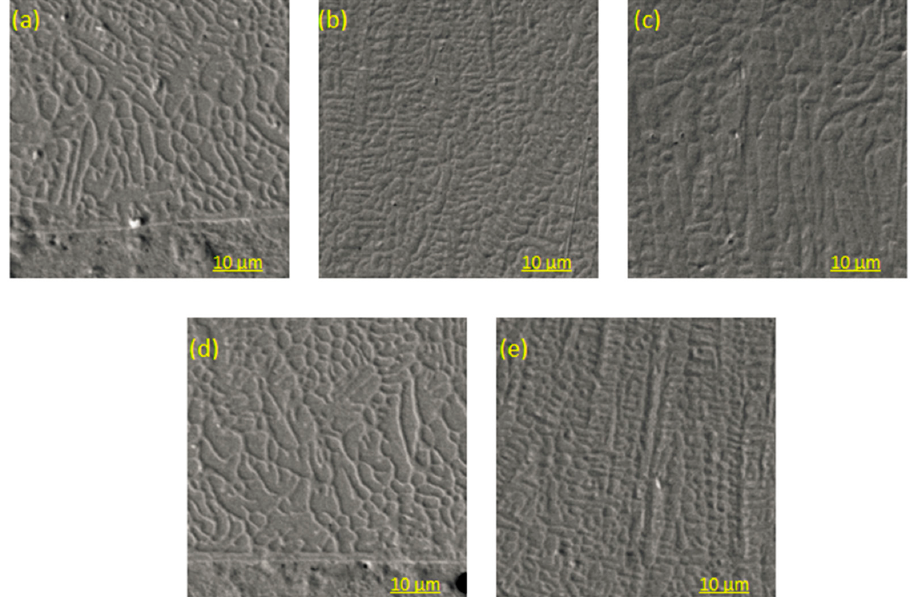
Figure 6. Microstructure of the cladding layers of Samples A and B. Organization morphology of Sample A: ( a ) lower area of the cladding layer; ( b ) middle area of the cladding layer; ( c ) upper area of the cladding layer. Organization morphology of Sample B: ( d ) lower area of the cladding layer; ( e ) middle area of the cladding layer.